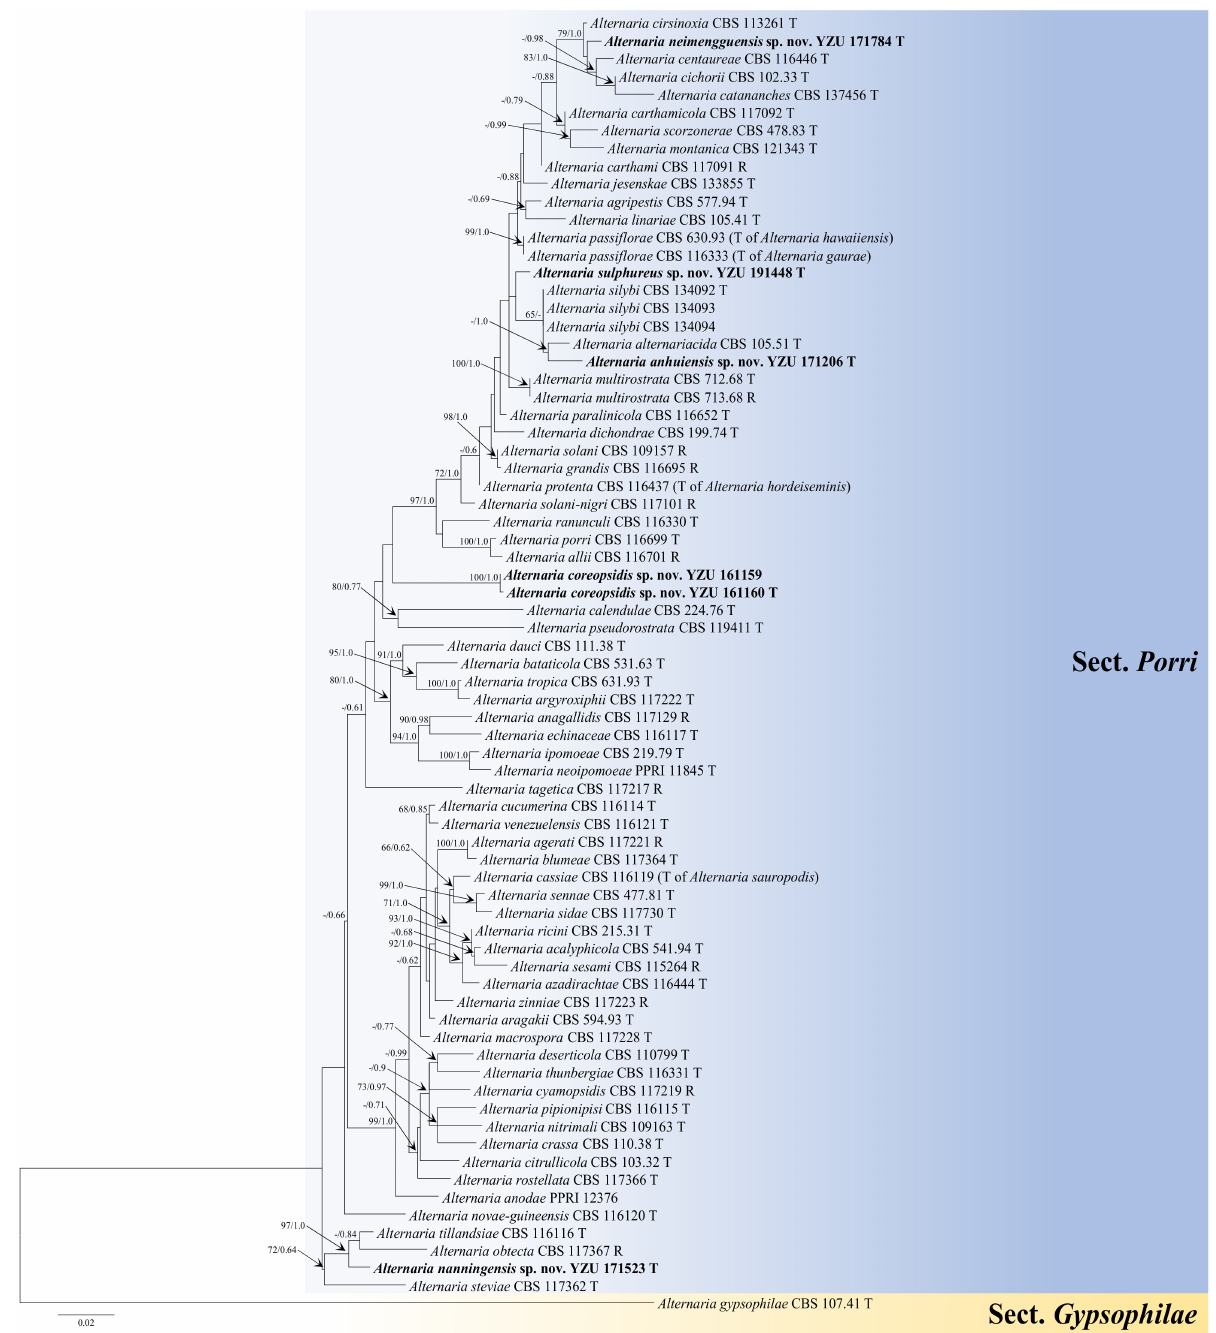
Figure 1. Maximum likelihood (ML) phylogram of new five Alternaria species from the Compositae family based on a combined dataset of ITS, GAPDH, Alt a 1, TEF1, and RPB2 gene sequences. The RAxML bootstrap support values >60%(ML) and Bayesian posterior probabilities >0.6 (PP) are given at the nodes (ML/PP). The present strains are in